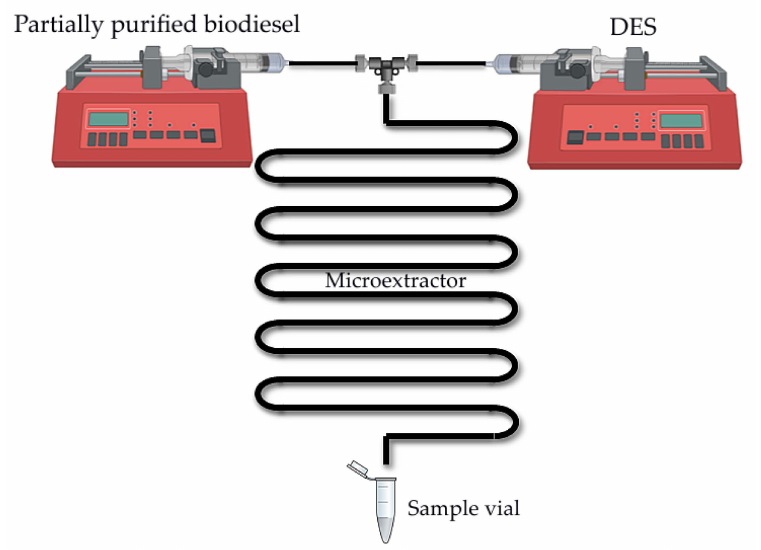
Figure 1. Scheme of the experimental set-up used for the biodiesel purification process in a